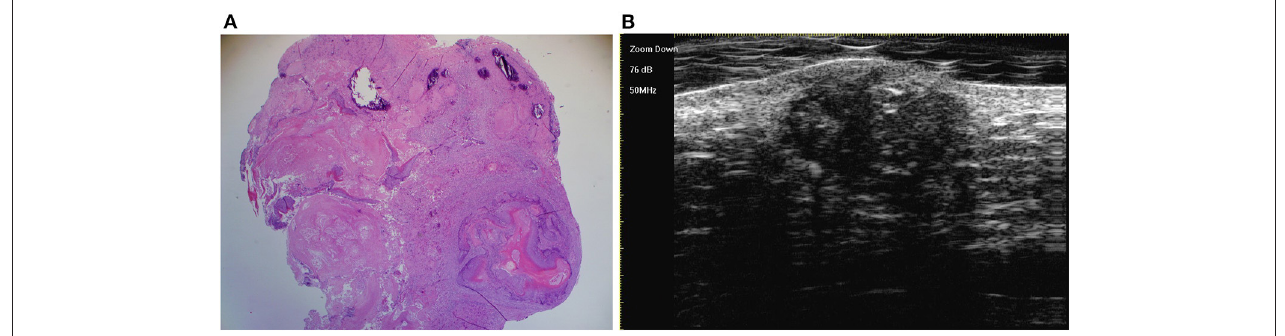
FIGURE 7 | The last three stages overlap in one lesion, which is detected by histology [ (A) original magnification × 25] and ultra-high frequency ultrasound (B)